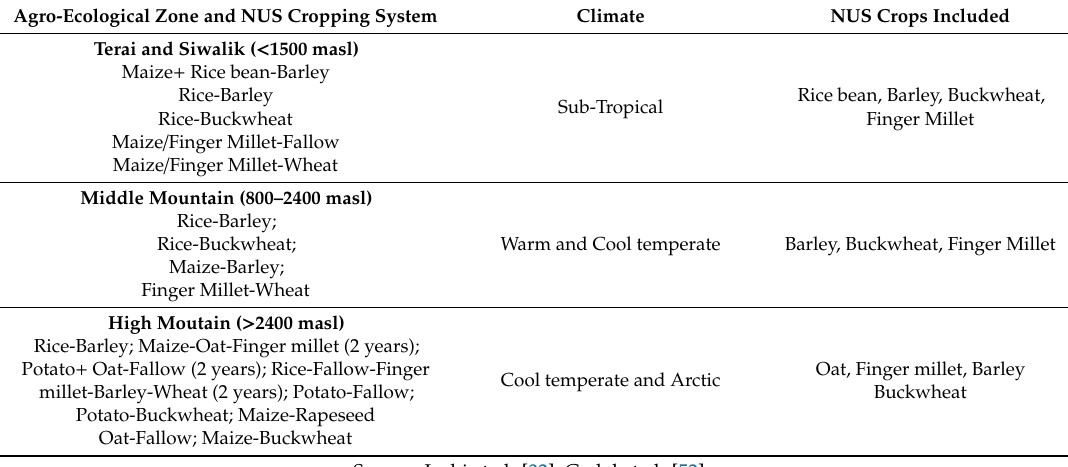
Table 1. Nutritionally important and underutilized species (NUS) include cropping systems in di ff erent climatic regions of